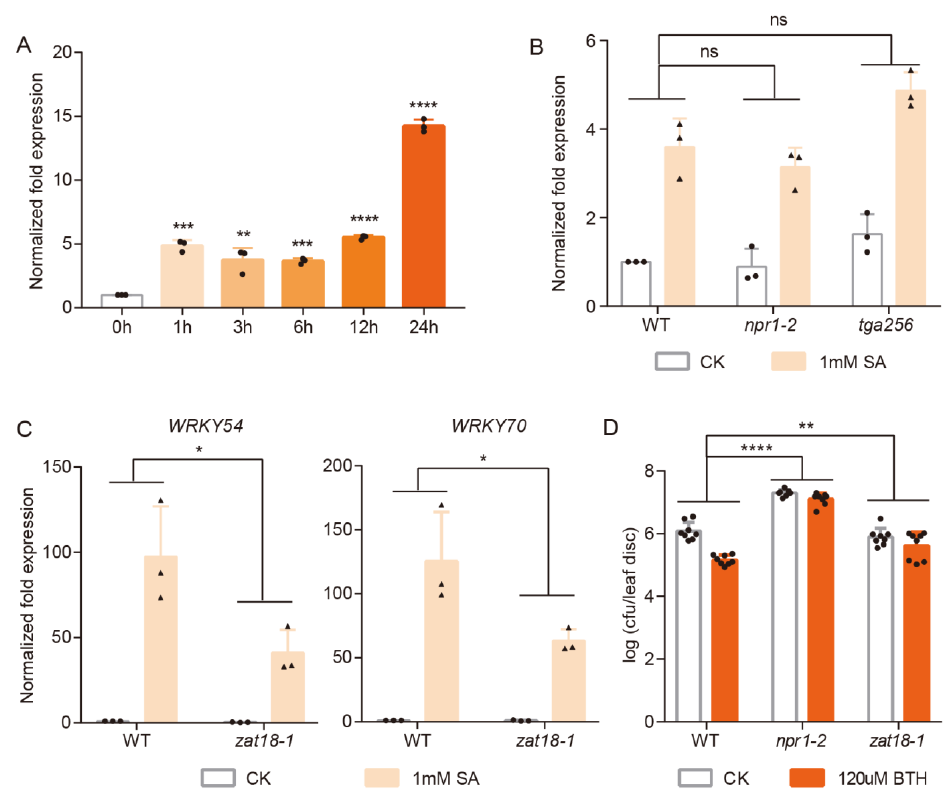
Figure 1. ZAT18 is an SA-induced gene that encodes a protein that is important for SA responses. ( A ) Two-week-old wild-type (WT) seedlings were dipped with 1 mM SA, and samples were collected at the indicated time points to examine the expression levels of ZAT18 with UBQ5 as a reference. Significant differences were detected using Student’s t -test. Data are shown as mean ± s.d. (n = 3, n indicates the number of biological replicates). ( B ) The expression levels of ZAT18 in the WT and npr1-2 and tga2/5/6 mutants after sterile dH 2 O (CK) or 1 mM SA treatment for 1 h. Experiments were performed as described in ( A ). Significant differences were detected using two-way ANOVA. Data are shown as mean ± s.d. (n = 3, n indicates the number of biological replicates). ( C ) The expression levels of WRKY54 and WRKY70 in the WT and zat18-1 mutant after sterile dH 2 O (CK) or 1 mM SA treatment for 1 h. Experiments were performed as described in ( A ). n = 3, n indicates the number of biological replicates. ( D ) Three-week-old WT and zat18-1 and npr1-2 mutants were pre-treated with dH 2 O (CK) or 120 µ M BTH for 1 day before infiltration with Psm ES4326 (OD 600nm = 0.001). The bacterial titer was checked at 3 days post-inoculation (dpi). cfu, colony forming unit. n = 8, n indicates the number of biological replicates. * p < 0.05; ** p < 0.01; *** p < 0.001; **** p < 0.0001; ns, no significant